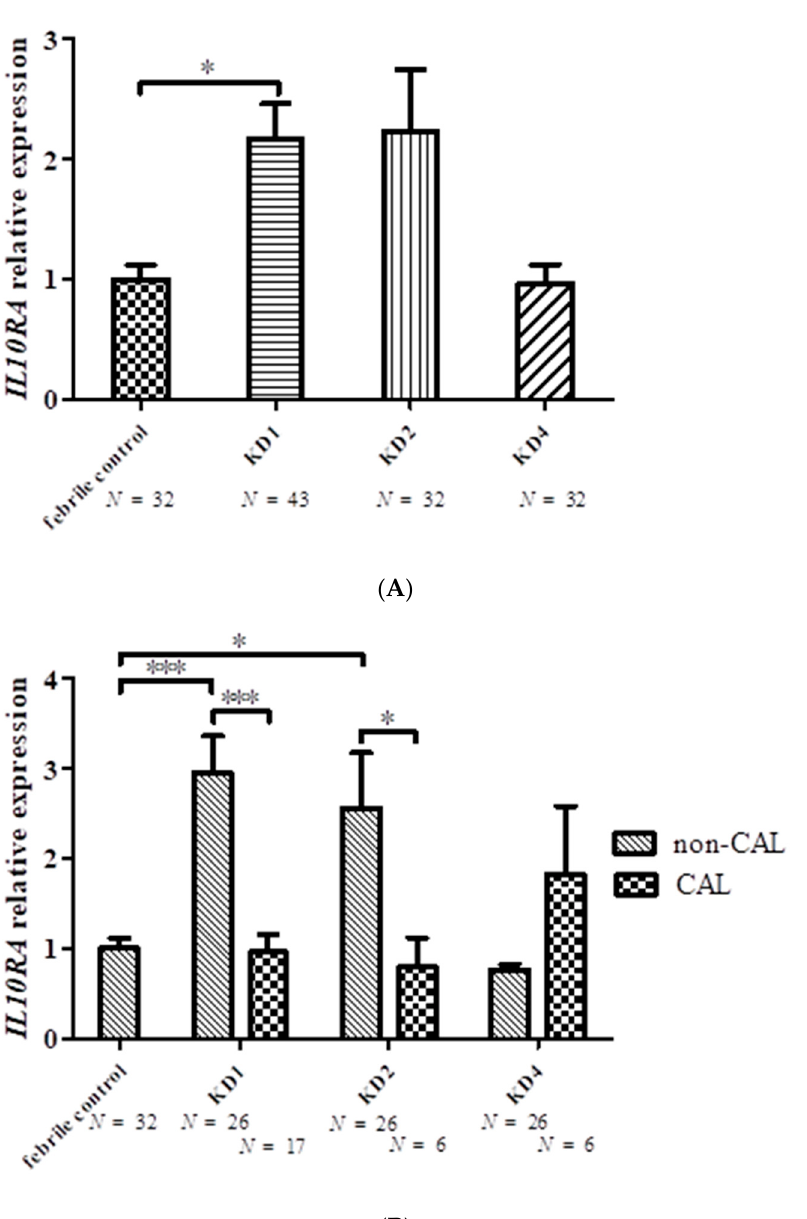
Figure 3. IL10RA mRNA levels ( A ) in febrile controls and patients with Kawasaki disease (KD1, before treatment; KD2, 3-7 days after treatment; KD4, six months after treatment); ( B ) in KD patients with and without coronary artery lesions (CAL). * denotes significance (* p < 0.05, *** p < 0.001) between controls and KD patients, and KD patients with and without CAL.